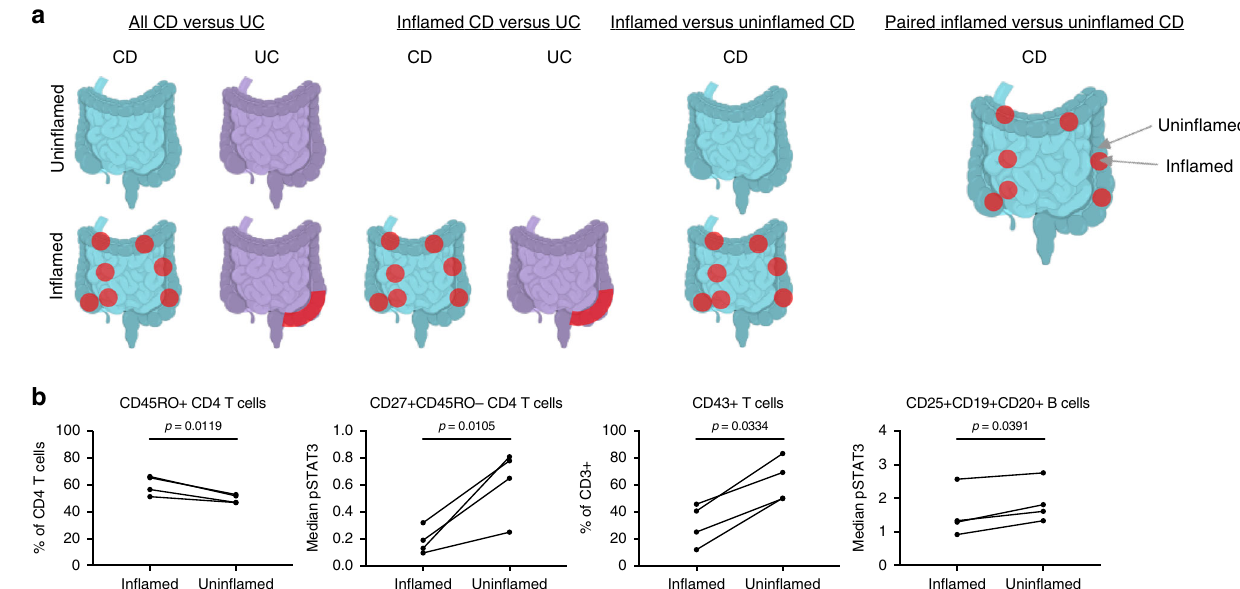
Fig. 6 Tissue leukocytes distinguish diseases and in fl ammation states. a Schematic of tissue comparisons. Created with BioRender. b Paired CD tissue from in fl amed and unin fl amed areas of the same region ( N = 4 pairs consisting of samples 239_1 and 239_4, 249_3 and 249_5, 252_1 and 252_3, and 255_1 and 255_3; see Supplementary Table 2). Statistics: ratio paired T test (df = 3; CD45RO + CD4 T cells, t = 5.48; CD27 + CD45RO − CD4 T cells, t = 5.74; CD43 + T cells, t = 3.76; CD25 + CD19 + CD20 + B cells, t = 3.51). P -values in b were not corrected for multiple testing because hypothesis-driven tests were conducted based on biological insight after independent preliminary analysis. Lines connect paired samples from the same subject. Source data are provided as a Source Data fi